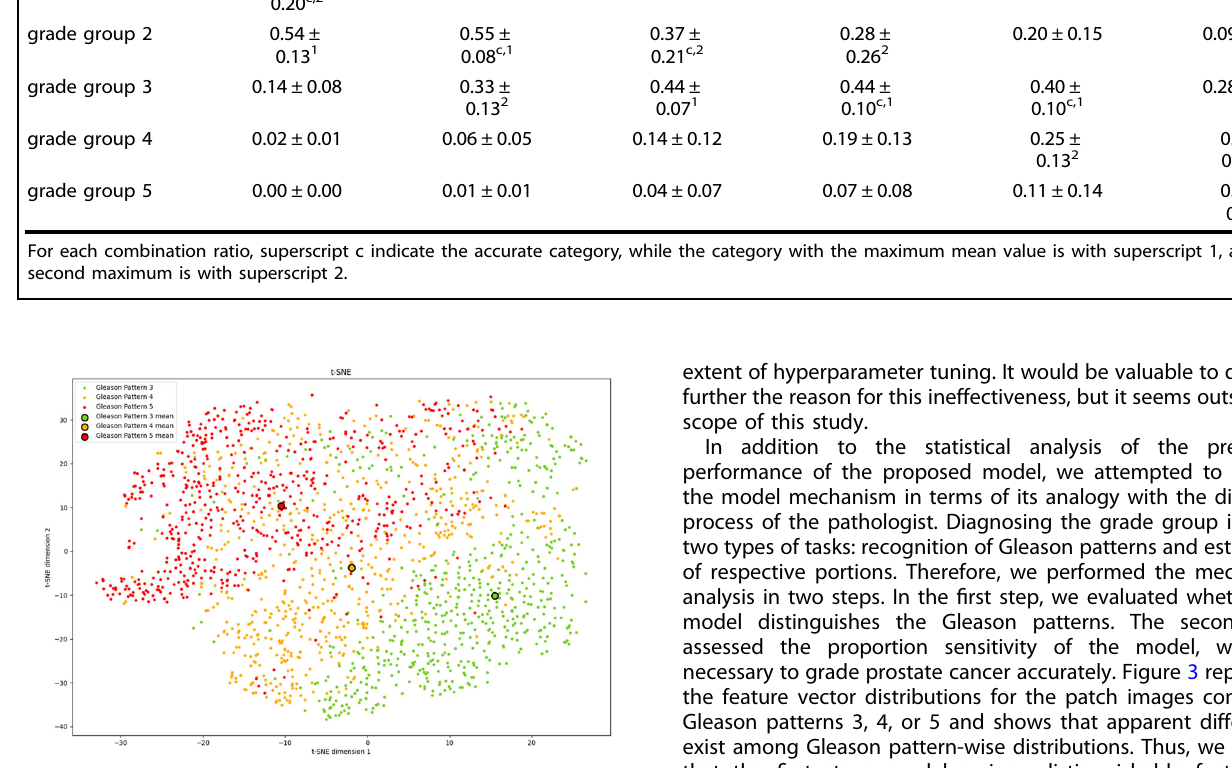
Fig. 3 t-SNE data visualization of the feature vectors of the Gleason pattern 3/4/5 image patches embedded by the fi rst stage model for perplexity 50 and 1000 iterations. Bigger dots correspond to the mean feature vectors.